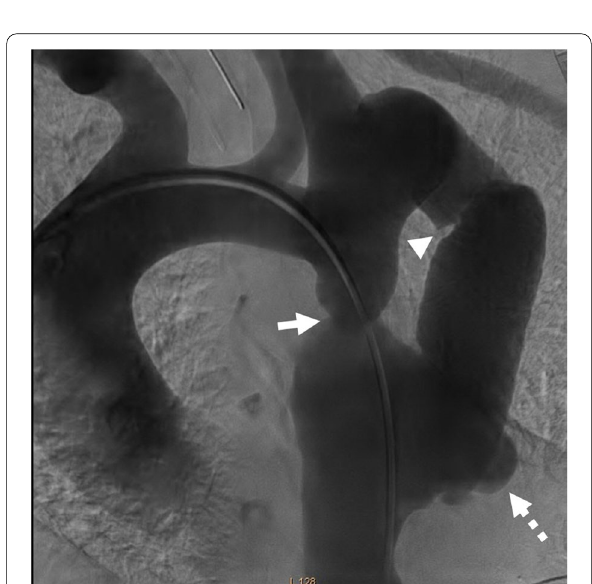
Fig. 4 Aortic root injection during fluorosocpy. Confirmed CT angiography results and depicted that proximal anastomotic site emanated from ostioproximal of left subclavian artery. arrowhead: tube graft, arrow: interruption site, dashed arrow: pseudoaneurysm of distal anastomotic